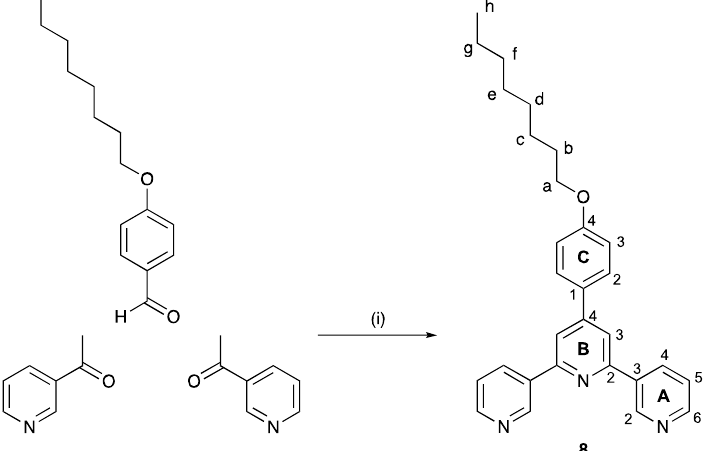
Table 2. Absorption maxima in the solution UV-VIS spectra of 6 , 8 and 9 (MeCN, 5 × 10 −5 mol·dm −3 for 6 and 8 , 2 × 10 −5 mol·dm −3 for 9 ).